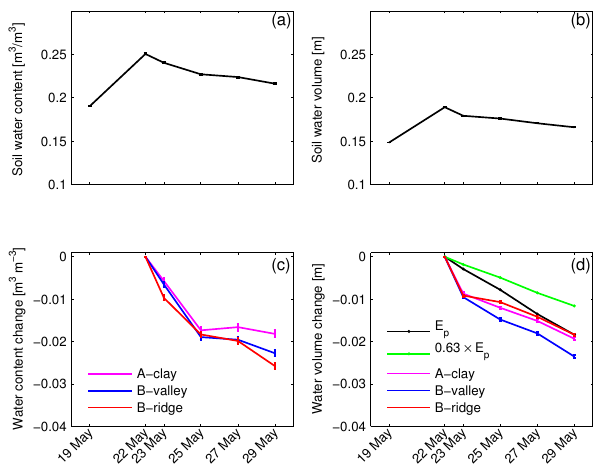
Fig. 10. Observations of the field-scale soil water dynamics at repre- sentative areas. (a) and (b) are the temporal changes of the averaged soil water content θ and the total water volume l w in the profile p25 (Fig. 3) through the rainfall event, respectively. (c) and (d) are the 2-D average changes at three areas with different structures (A: clay patches, B: dune valley and dune ridge). Water loss by evaporation is given in (d) , where E p is pan evaporation, and 0.63 × E p is an roughly estimation of the actual field